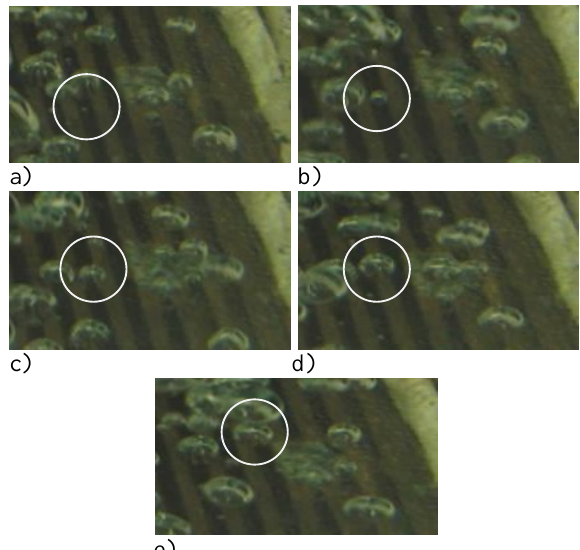
Fig. 9. Visualization observations of pool boiling of ethanol on the microchannel surface MCV-0.5-0.2_2.8-1, q = 30 kW/m 2 , a) d = 0.25 mm, b) d = 0.5 mm, c) d =0.75 mm, d) d = 0.90 mm, e) d = 1.20